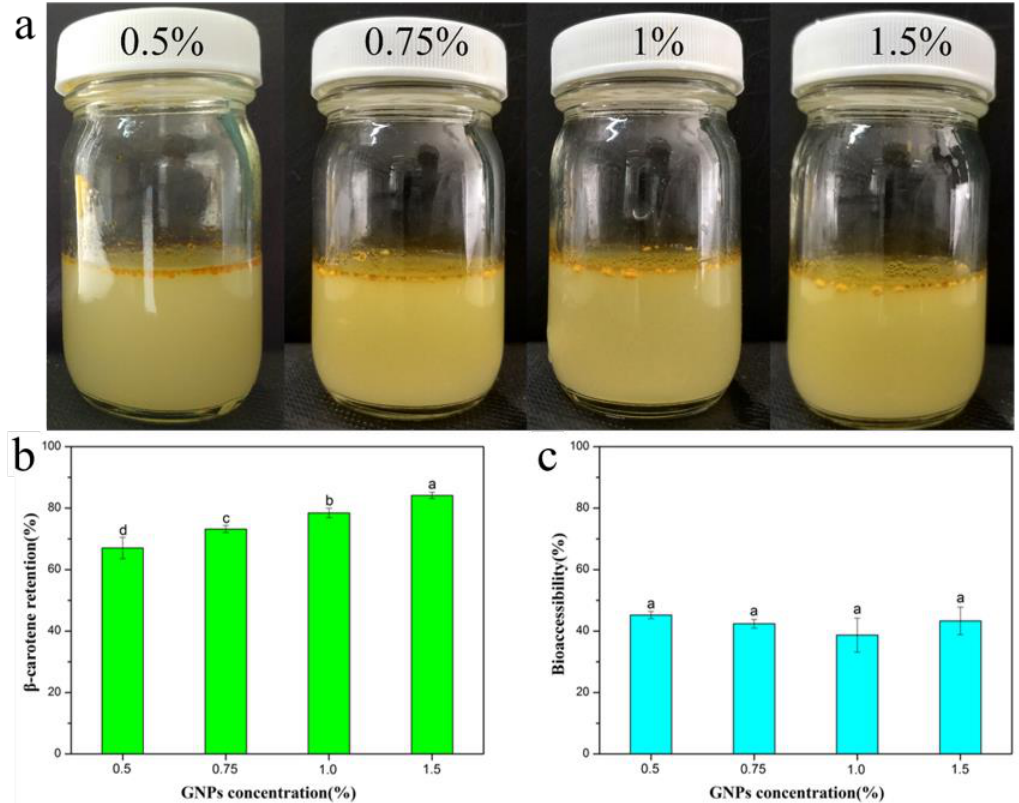
Figure 6. ( a ) Visual images of Pickering emulgels after the simulated gastric digestion, ( b ) β -carotene retention, and ( c ) bioaccessibility of GNPs Pickering emulgels during the simulated intestinal